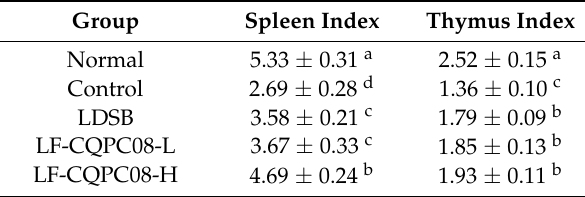
Table 2. Effect of Lactobacillus fermentum CQPC08 on immune organ index in mice with tongue cancer. Group Spleen Index Thymus Index